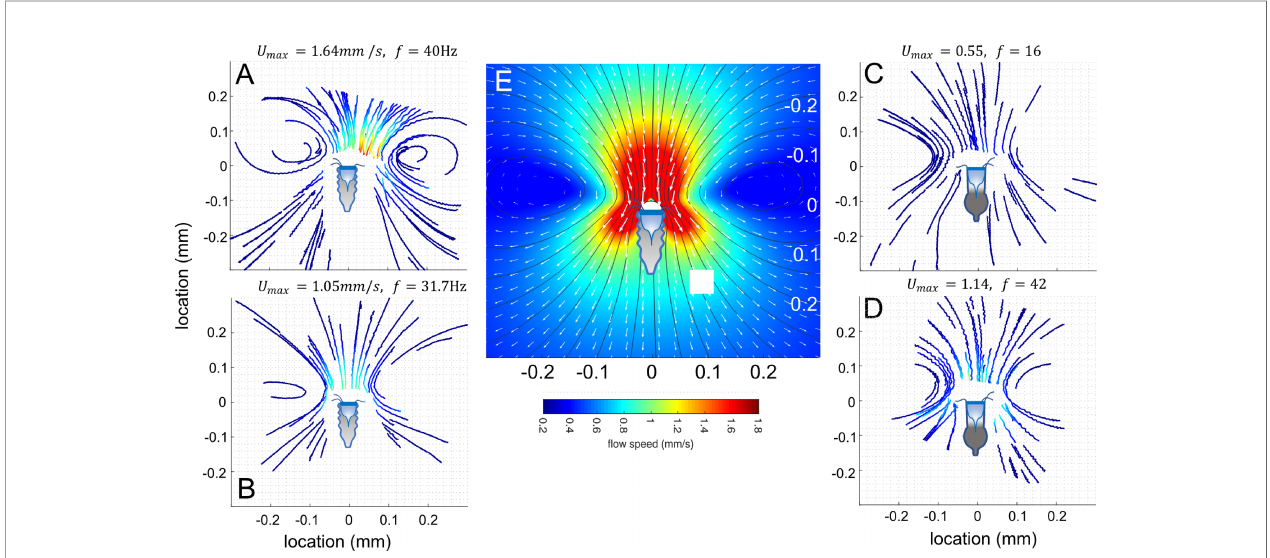
FIGURE 3 | The fl ow fi elds generated by the tintinnids. PTV tracks for Climacocilys scalaria (A, B) and Codonellopsis orthoceras (C, D) . Tracks are colored by the particle ’ s speed; the maximal speed in the fi eld and the cilia beat frequency are indicated above each panel. (E) A numerical solution to the Brinkman approximation to Stokes equations (eq. 1-4), optimized using the PTV results. Colors represent fl ow speeds, arrows velocity vectors, and thin black lines the streamlines. Prior to PTV analysis, videos were rotated and shifted such that the center of the oral area of the tintinnid was at the origin (0,0) of a cylindrical coordinate system, and the mouth centerline on the x-axis. Illustrated tintinnids are to